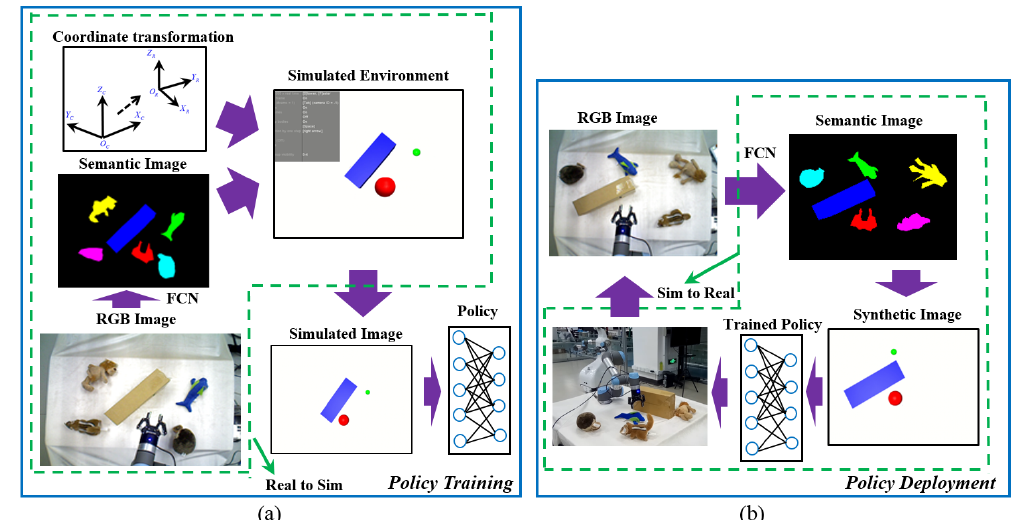
Figure 1. Illustration of the proposed real–sim–real (RSR) transfer learning pipeline. ( a ) Real-to-sim training phase. A task-related simulated environment is generated based on coordinate transformation and semantic images of real-world robot working scenarios. A policy network is trained in the constructed simulated environment with the deep reinforcement learning (DRL)